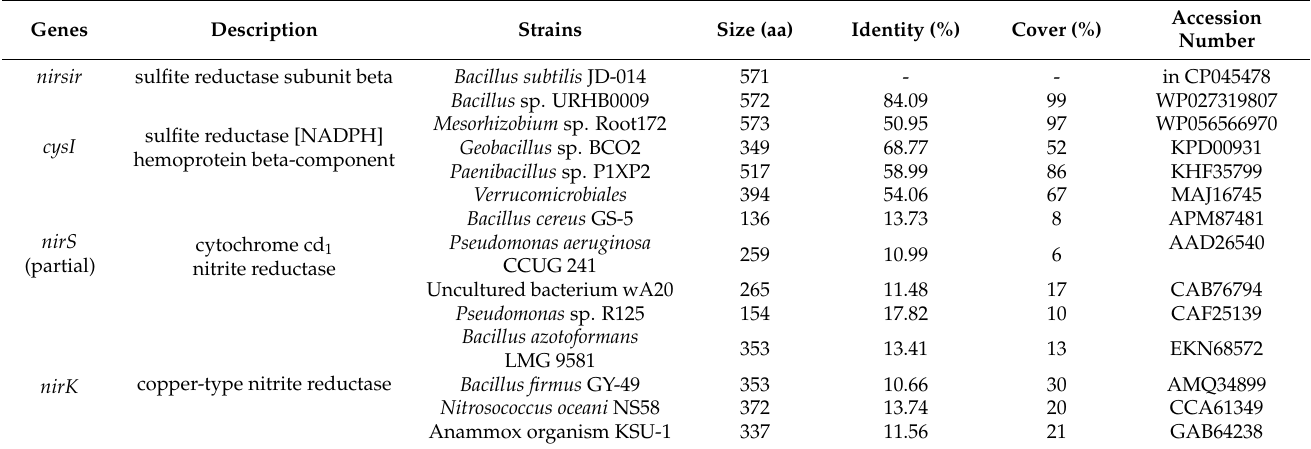
Table 1. Comparison of nirsir with cysI and nirS / nirK in classical